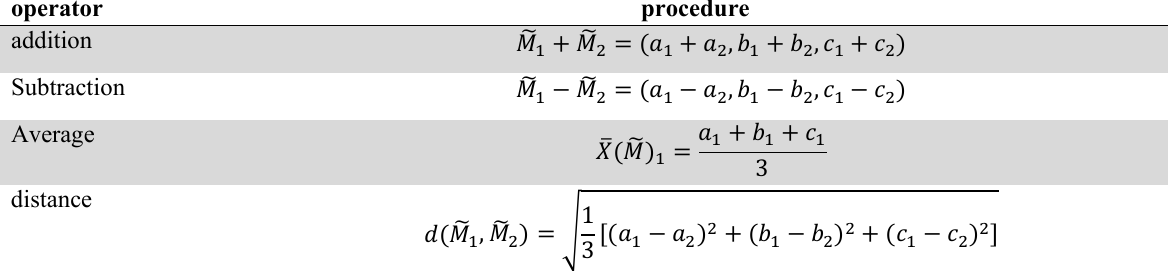
The most important algebraic operation for two triangular fuzzy